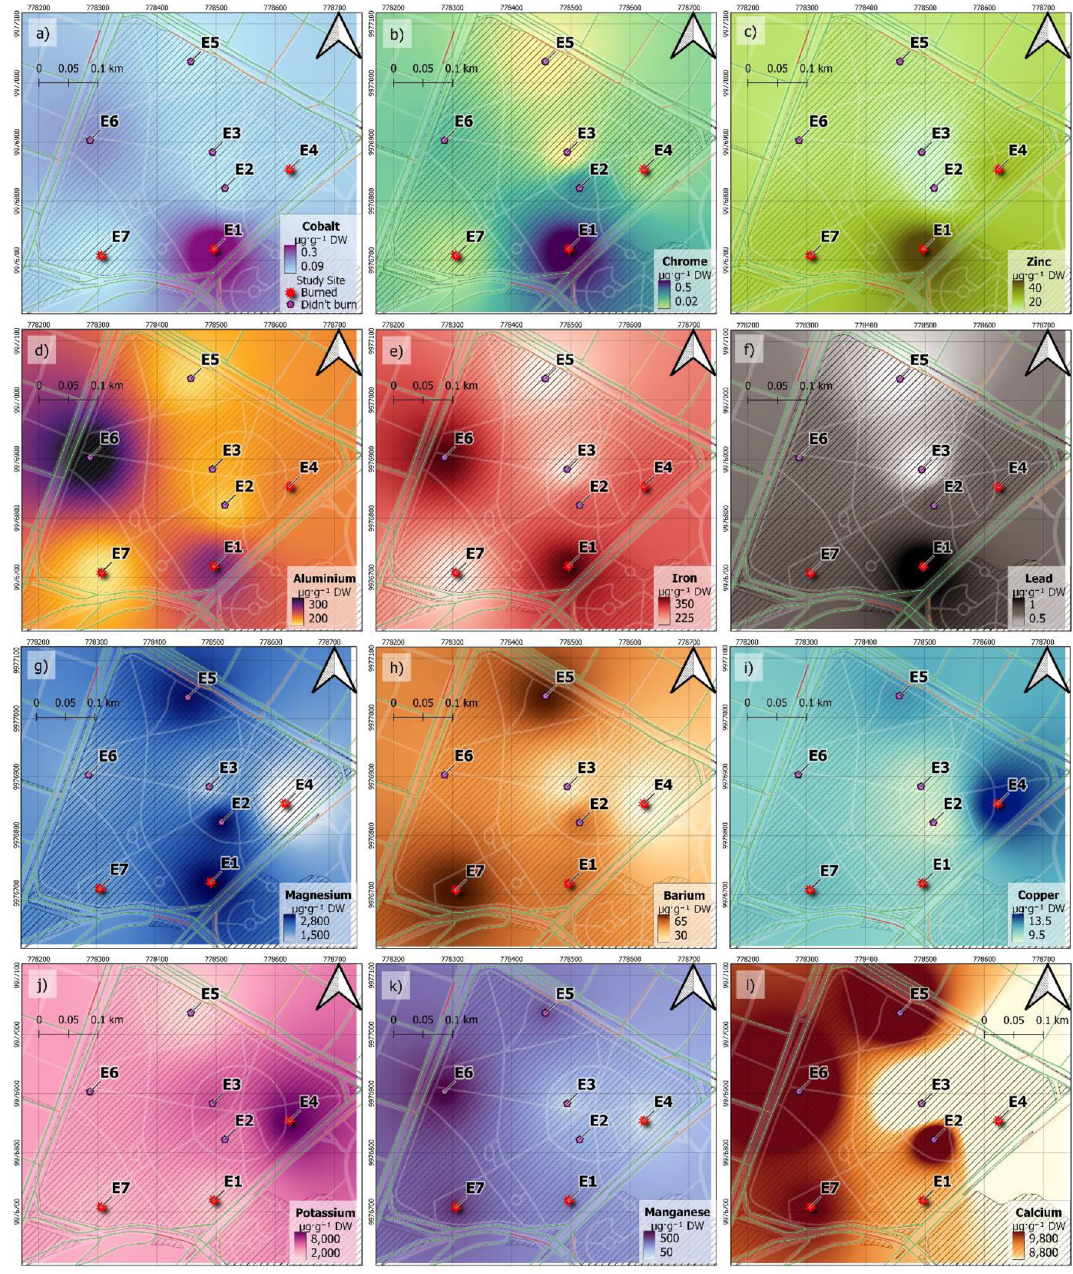
Figure 4. Distribution patterns of the concentration, μg g −1 DW, of metals found in the Melaleuca armillaris leaves collected at the urban El Ejido park two days after the national protests (October 15, 2019). Red markers: points with obvious burning signs at the moment of the sampling collection, E4 was marked with red marker as it is located just in front of a blockage of the road, where tires were burned. Red lines indicate common transects of traffic congestion (Google Maps Traffic). Geographical Information Software QGIS 3.18.2 was used ( available at https:// qgis. org/ downl oads/), employing ESPG 4326 (WGS Pb (Fig. 4f), Mg (Fig. 4g) and Ba (Fig. 4h). Those metals are typically used in tire manufacture 27,28,45 . Cu is also known to make part of the composition of tires 27,28 , and its concentration was higher at point E4 (Fig. 4i). At point E4, visible burn signs were not observed at the moment of the sampling. However, it is located just in front of a street where there was a barricade (Fig. 5c) with an intense burning of materials during the protests, mainly tires. At E4 an elevated concentration of K, which is a tracer of biomass burning, was also observed (Fig. 4j). While K is often a good marker of biomass burning, it is also one of the chemical components naturally present in the plants. This might suggest that while at E1 and E7 mostly tires were burned, at E4 there was a mix of pol- lutants. As previously mentioned, protesters often burn wood to reduce the eye burning due to the tear gas, but also burn tires and other objects to create a dark smoke and block roads (Figure A3, Appendix 1). Finally, site